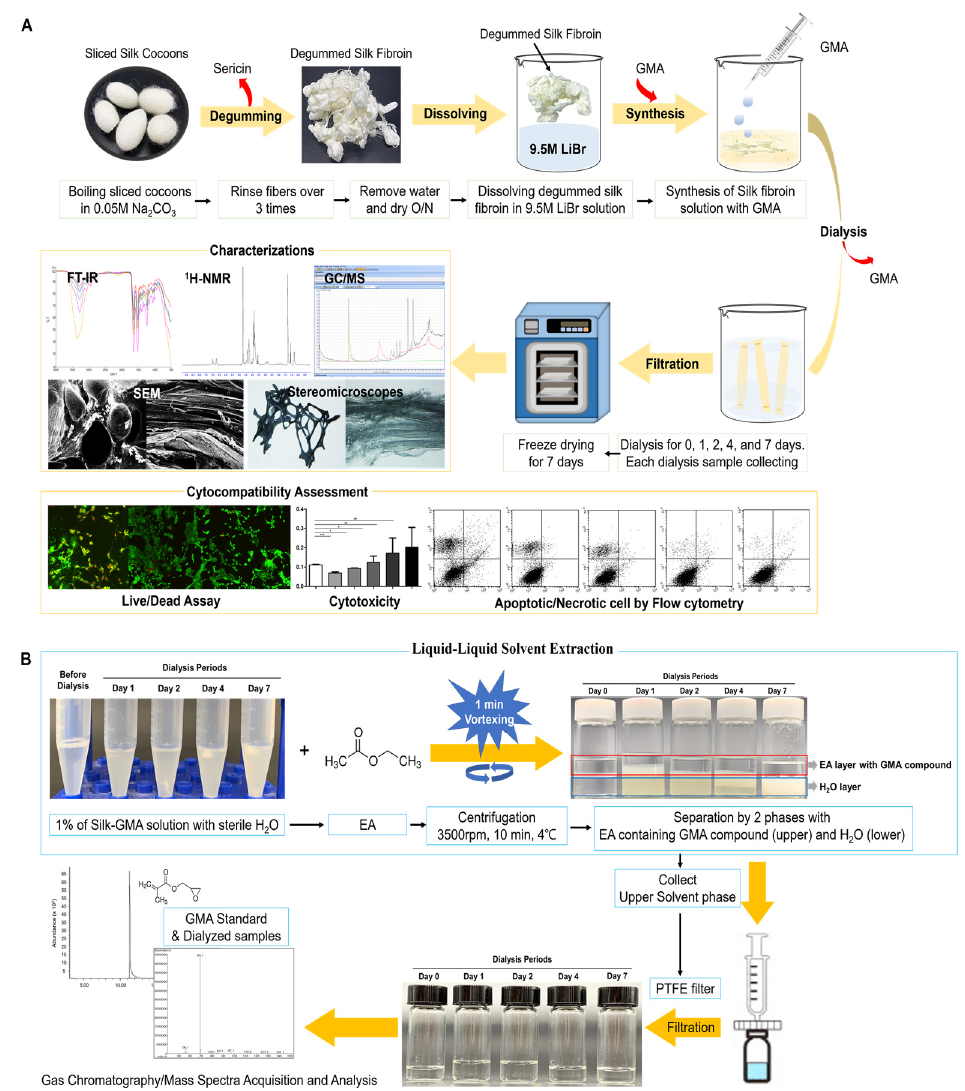
Figure 1. A schematic illustration of the biocompatibility screening procedures for modified silk fibroin with glycidyl methacrylate (Silk-GMA). ( A ). For the manufacturing, SF (acronym definitions below) was chemically modified with GMA. Degummed silk was dissolved in 9.3 M LiBr and the solutions were set to react with GMA for 6 h at 60 °C. Then, it was dialyzed with distilled water at room temperature for seven days and then freeze-dried for up to seven days. ( B ). The liquid–liquid extraction method was used for application to GC-MS to detect the residual glycidyl methacrylate on each dialysis modified SF with GMA samples. Using the 2-phase separation method with EA, the upper phase was collected for GC-MS acquisition. On GC-MS acquisition, each extracted sample was injected and helium as a carrier gas and capillary column was used. The scanning range was between 35 and 200 m / z (Table 1). SF, silk fibroin; GMA, glycidyl methacrylate; Silk-GMA, modified silk fibroin with glycidyl methacrylate; LiBr, lithium bromide; EA, ethyl acetate;